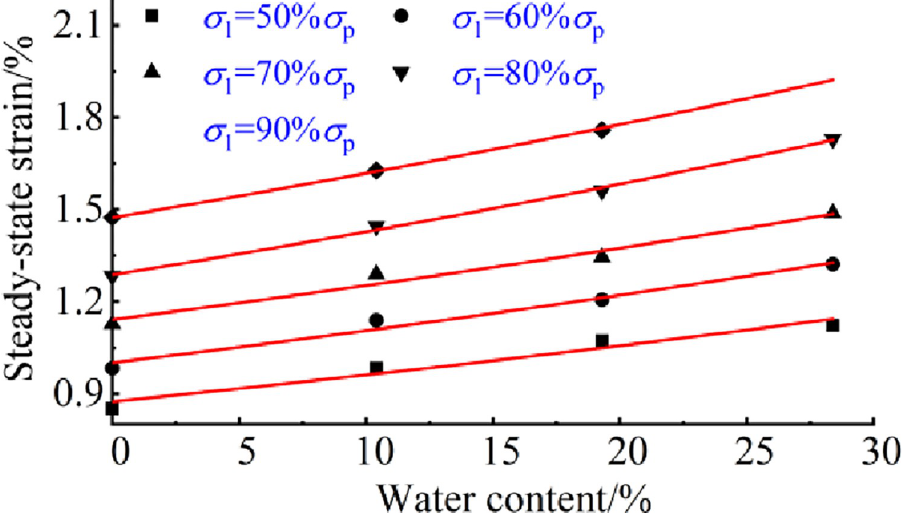
Fig 8. Steady-state strain curves for specimens with different water